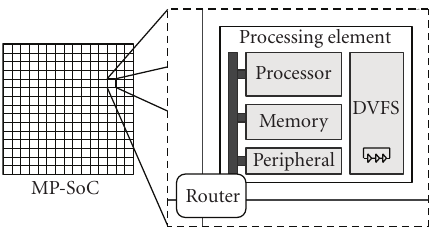
Figure 1: MP-SoC with hundreds of processing elements con- nected by an NoC. Each PE integrates a